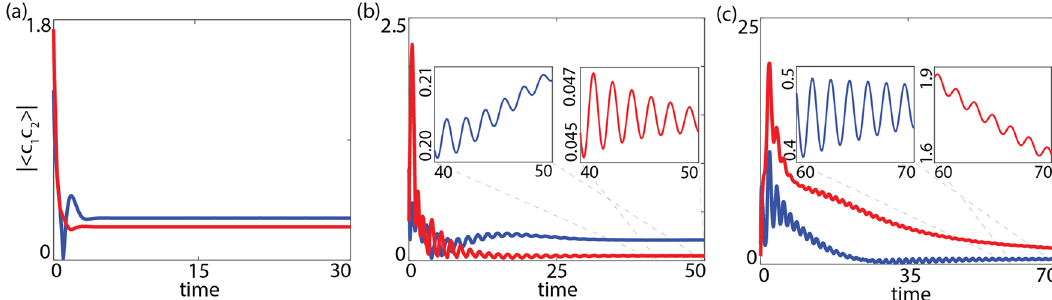
Fig. 2 Multistability and non-stationary behavior vs. the system size. Time evolution of the fi rst and the second site correlation ( jh ^ c 1 ^ c 2 ij ) showcasing the multistability for two randomized initial states and the oscillatory behavior for various chain length of a N = 4, b N = 12, and c N = 100 subject to the periodic boundary condition. Blue and red lines correspond to two different randomized initial conditions.